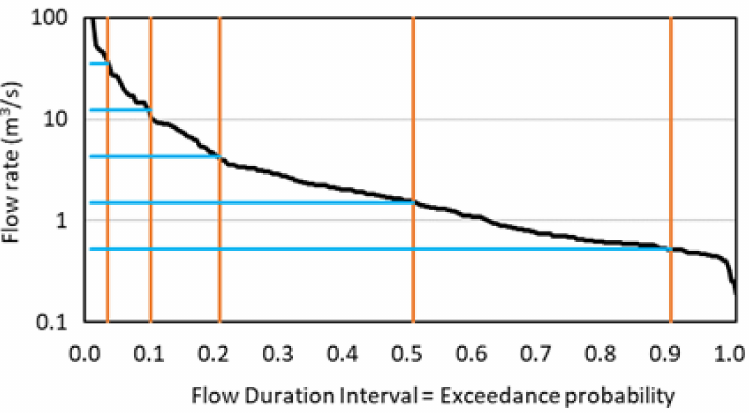
Figure 6. Example of the flow duration curve used in our approach (vertical lines delimit the six flow intervals and the blue horizontal lines show the equivalent “thickness” of the high